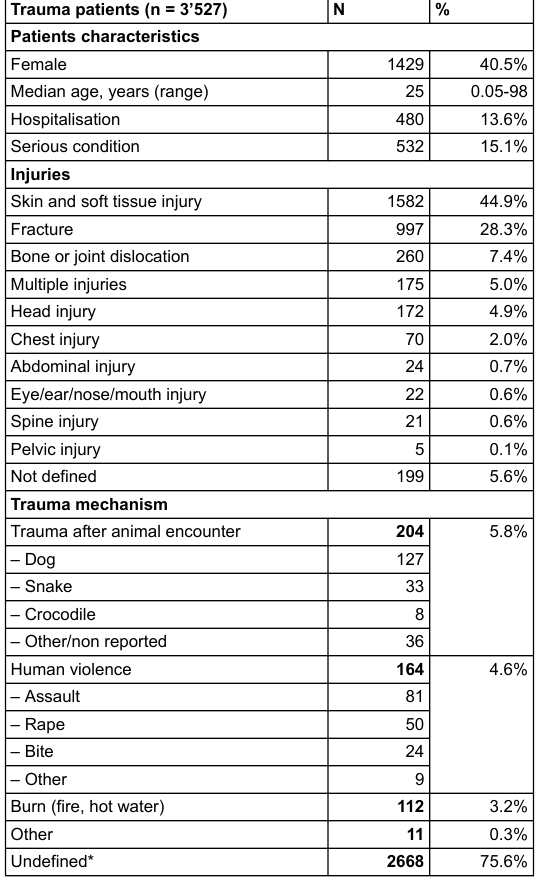
Table 4: Description of trauma